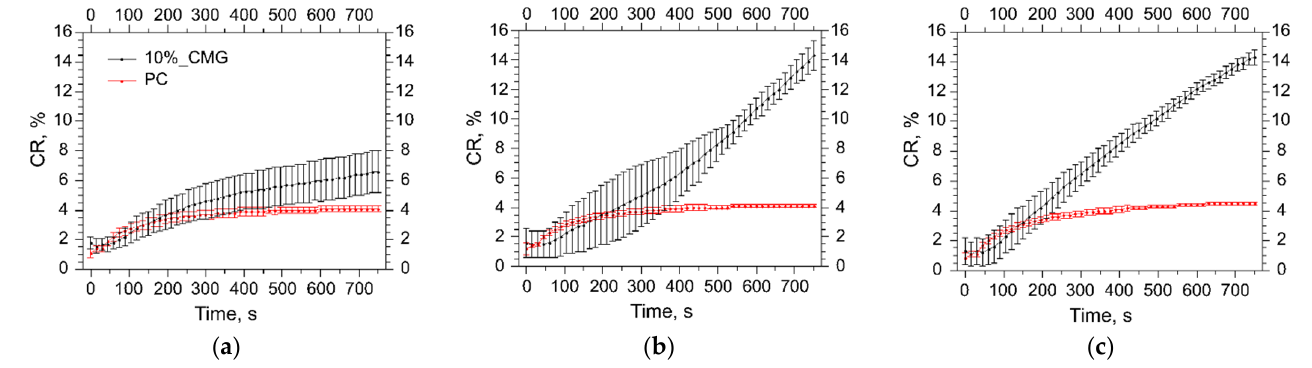
Figure 5. Calcein release (CR, %) from PC (red line) and 10CMG (black line) liposomes in albumin solution: 0.4 mg/mL ( a ); 4 mg/mL ( b ); 40 mg/mL ( c ). Means ± SD (n=3) values are presented.